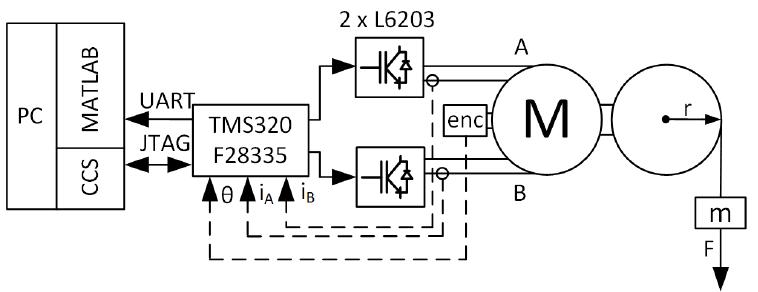
Figure 11. Schematic of the test